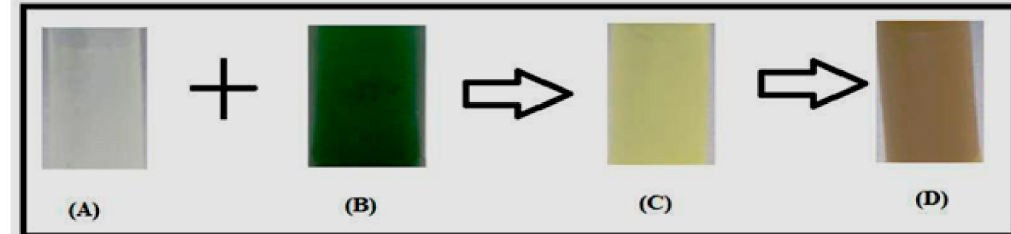
Figure 2. Formation of Zinc nanoparticles; ( A ) Eucalyptus broth, ( B ) one mM Zinc nitrate solution, ( C ) Reaction mixture and ( D ) Zinc nanoparticle